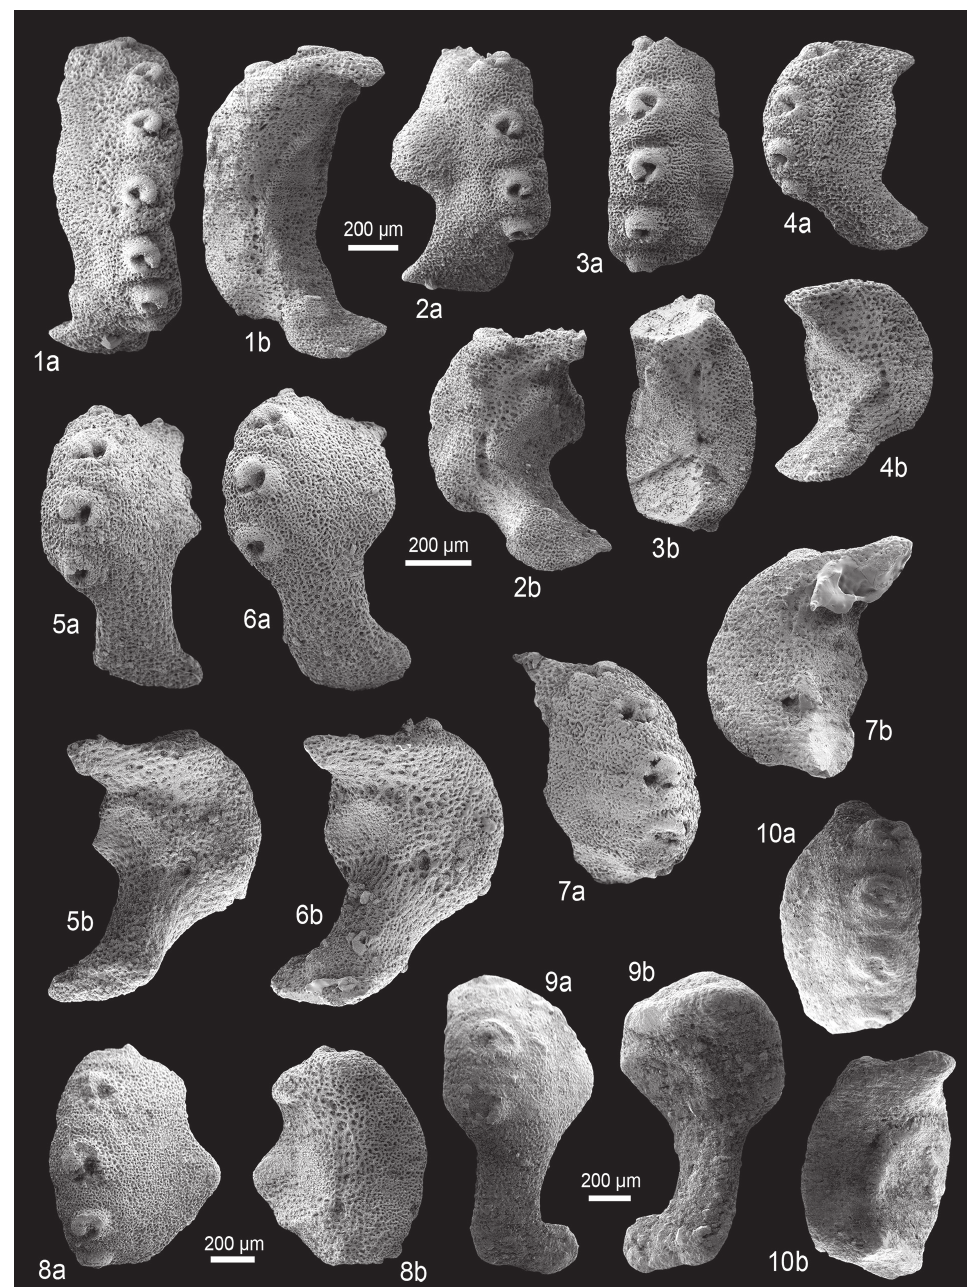
Fig. 38. Fossil lateral arm plates (LAPs) of ophiacanthid brittle stars in external (a) and internal (b) views. 1-4. Ophiojagtus irimurai gen. et sp. nov. from the early Kimmeridgian (Late Jurassic) of the Pointe du Chay, France. 1. GZG.INV.78808 (holotype), proximal LAP. 2. GZG.INV.78809 (paratype), median LAP. 3. GZG.INV.78810 (paratype), median LAP. 4. GZG.INV.78811 (paratype), distal LAP. 5-7. Ophiojagtus acklesi gen. et sp. nov. from the late Aptian (Early Cretaceous) of Wizard Way, Texas. 5. GZG.INV.78814 (holotype), proximal LAP. 6. GZG.INV.78815 (paratype), median to distal LAP. 7. GZG.INV.78816 (paratype), proximal LAP. 8. Ophiojagtus sp. 1 from the early Cenomanian (Late Cretaceous) of Waco, Texas; proximal LAP. 9-10. Ophiojagtus alternatus (Kutscher & Jagt, 2000) comb. nov. from the early late Maastrichtian (Late Cretaceous) of Haccourt, Belgium. 9. NHMM 2012 060, proximal to median LAP. 10. NHMM 2012 061, proximal LAP. One common scale bar per